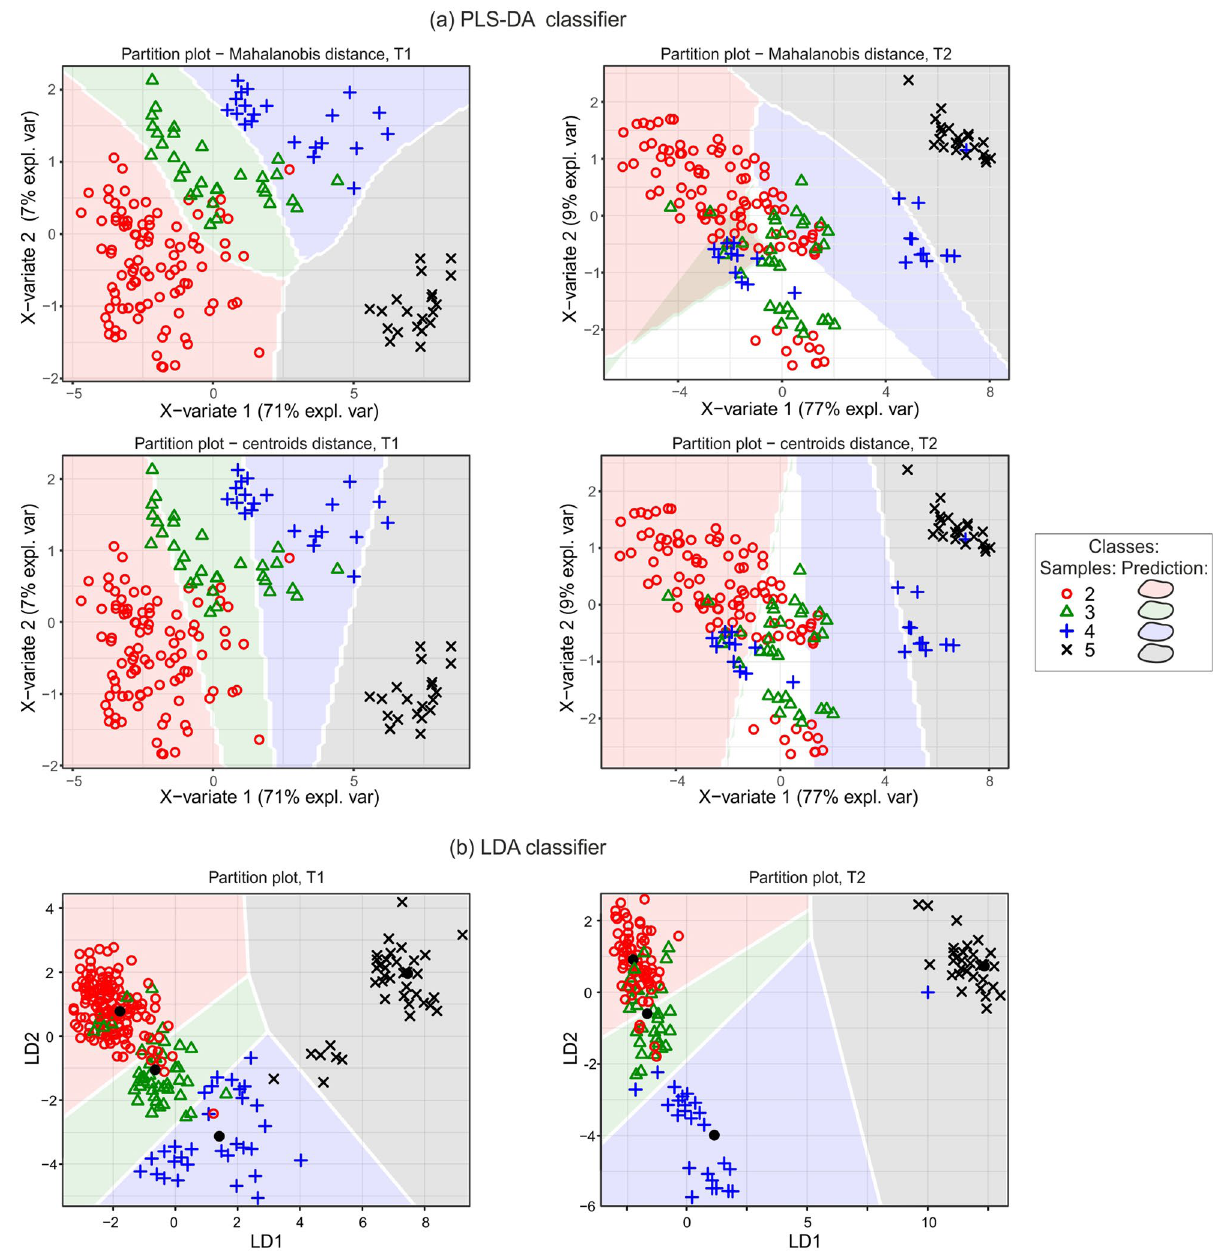
Figure 6. PLS-DA and LDA classifier prediction results for textural feature samples in the plain of the first two linear discriminant